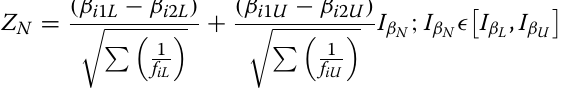
Non-distressed couples W tN + 1